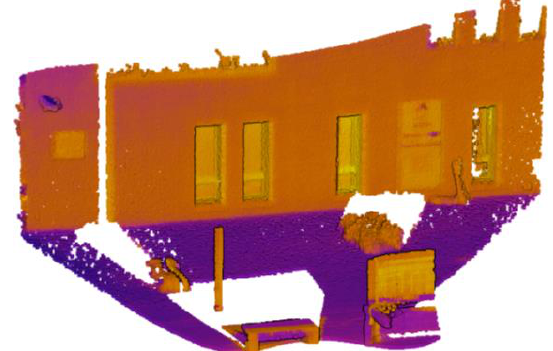
Figure 12: LiDAR point cloud coloured with the thermal camera data after the calibration